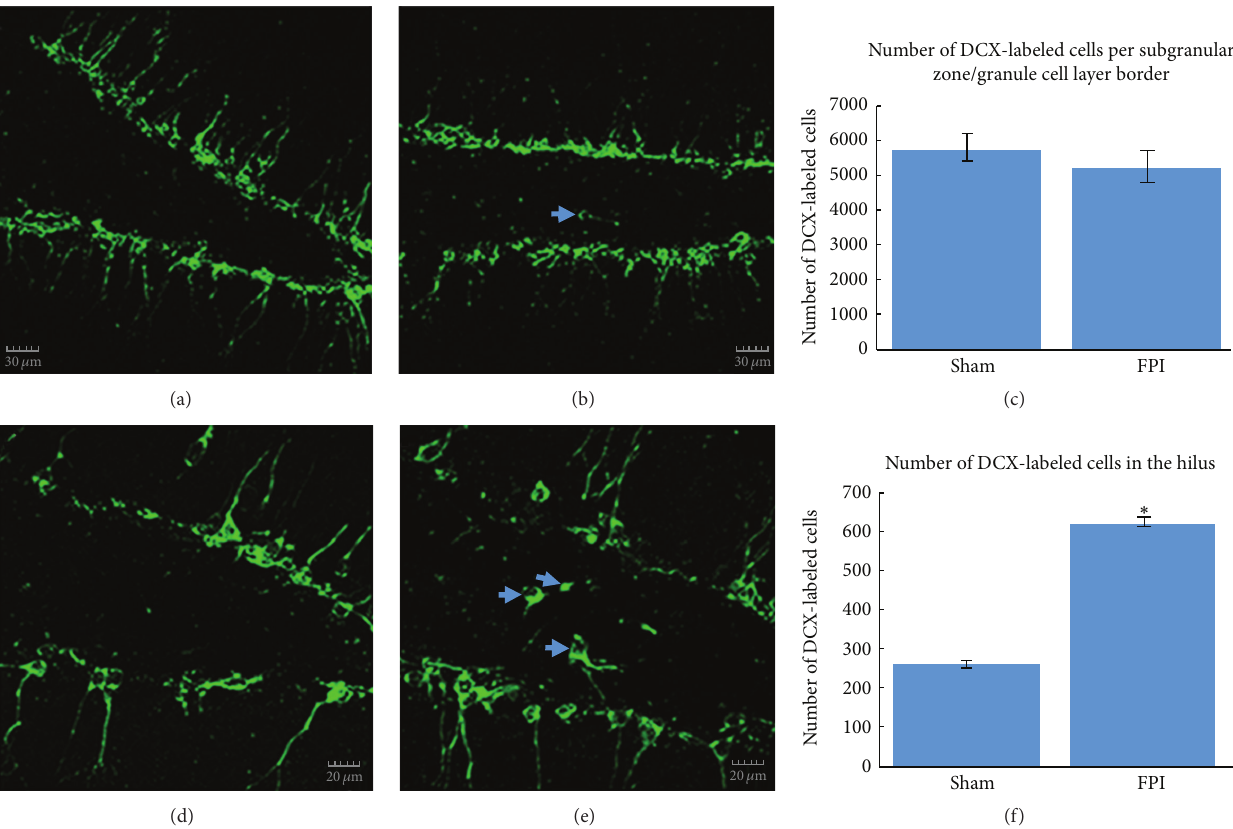
Figure 2: DCX-labeled immature neurons in the dentate gyrus. In (a), a relatively low magnification confocal micrograph is shown to depict both the infrapyramidal and suprapyramidal blades, as well as the hilus from a sham mouse. In (b), a fluorescent micrograph from an FPI mouse illustrates that, despite no significant differences in the number of DCX-labeled cells, the overall appearance of the DCX-labeled cells in the dentate gyrus is altered, as can be seen by the hilar ectopic granule cell (arrow). In (c), quantitative analysis of DCX-labeled cells at the subgranular zone/granule cell layer border revealed no significant differences between sham mice and FPI mice at 30 days after injury. In (d), a higher magnification confocal micrograph is shown to illustrate the typical appearance of granule cells in the dentate gyrus in a sham mouse. In (e), the confocal micrograph at higher magnification from an FPI mouse shows a relatively robust number of DCX-labeled hilar ectopic granule cells (arrows) at 30 days after a TBI. Such cells have been implicated in proepileptogenic circuits. In (f), quantitative analysis of the number of DCX-labeled hilar ectopic cells revealed a significant increase ( ∗ 𝑃 < 0.009 ) in FPI mice compared to sham mice. Scale bars in (a) & (b) = 30 𝜇 m and in (d) & (e) = 20 𝜇